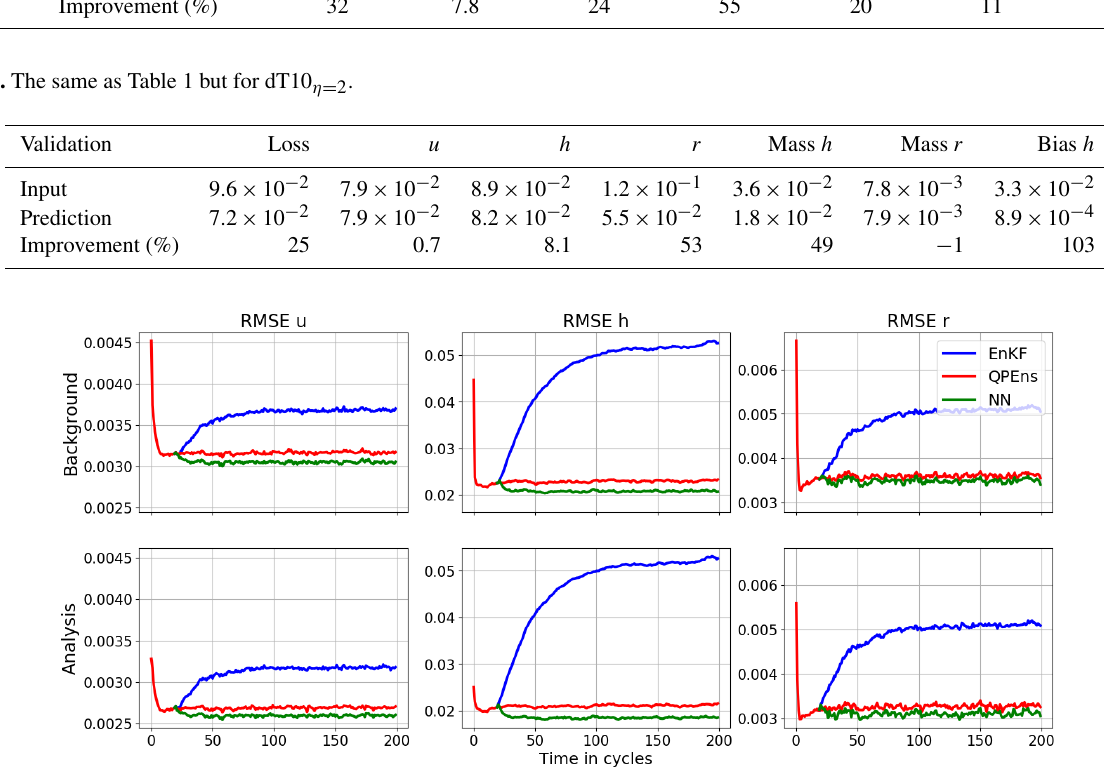
where the negative sign indicates that the CNN corrects more in clear regions than in cloudy